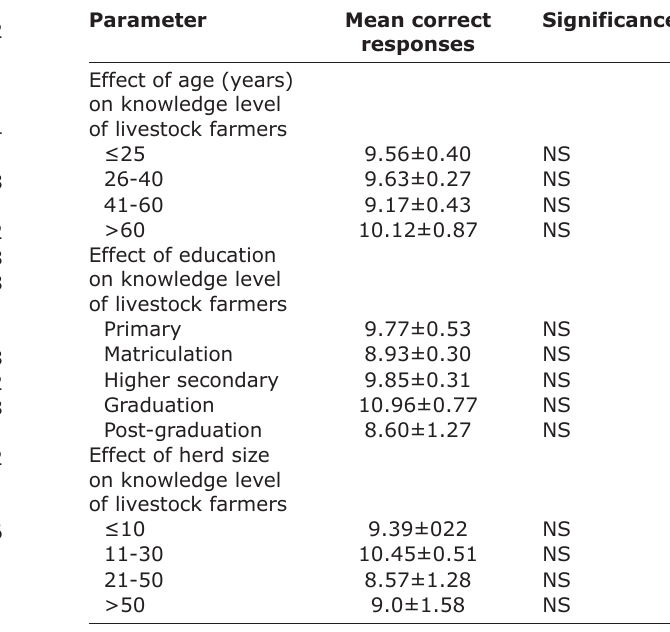
Table-4: Effect of age, education and herd size on knowledge level of livestock farmers toward zoonotic